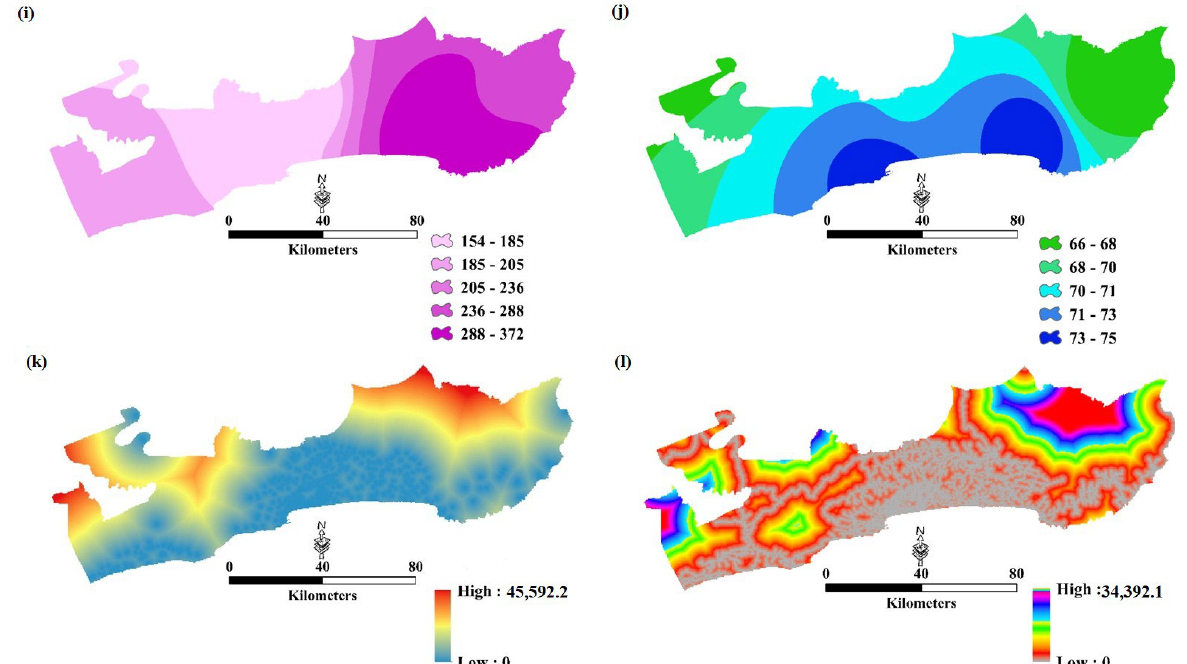
Figure 9. Spatial distribution of the NDVI condition factors: ( a ) elevation, ( b ) soil map, ( c ) slope, ( d ) aspect, ( e ) topographic wetness index, ( f ) golgoy map, ( g ) culvature, ( h ) temperature, ( i ) rainfall, ( j ) humidity, ( k ) distance to urban area, and ( l ) distance to roads.